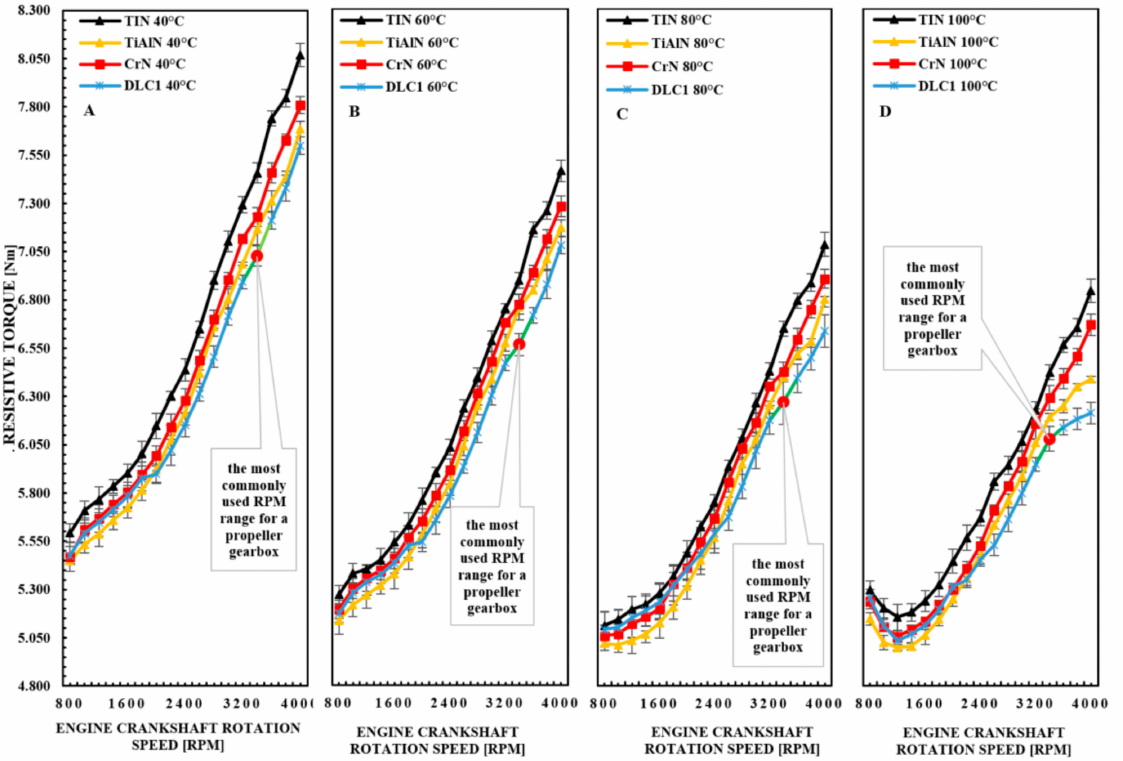
Figure 6. Waveforms of the engine resistance to motion for the TiN (pak1-p1), TiAlN (pak1-p2), CrN (pak1-p3) and DLC1 (pak1-p4) coatings at an oil temperature of ( A ) 40, ( B ) 60 ( C ) 80 and ( D ) 100 ◦ C in the rotational speed range shaft from 800 to 4000